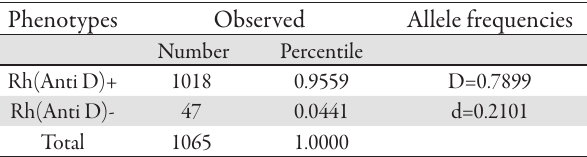
Tab. 8. Rh blood group among OBC population